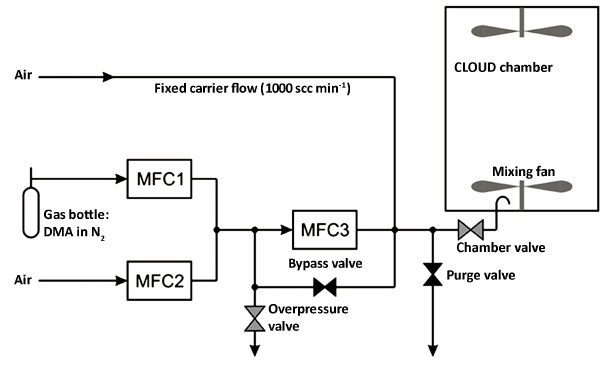
Figure 1. CLOUD chamber and gas system for delivering DMA to the chamber. Three mass flow controllers (MFC1 to MFC3) and several valves are used to control the flow rates. The figure indicates a setting where the bypass and the purge valve are closed while the other valves are